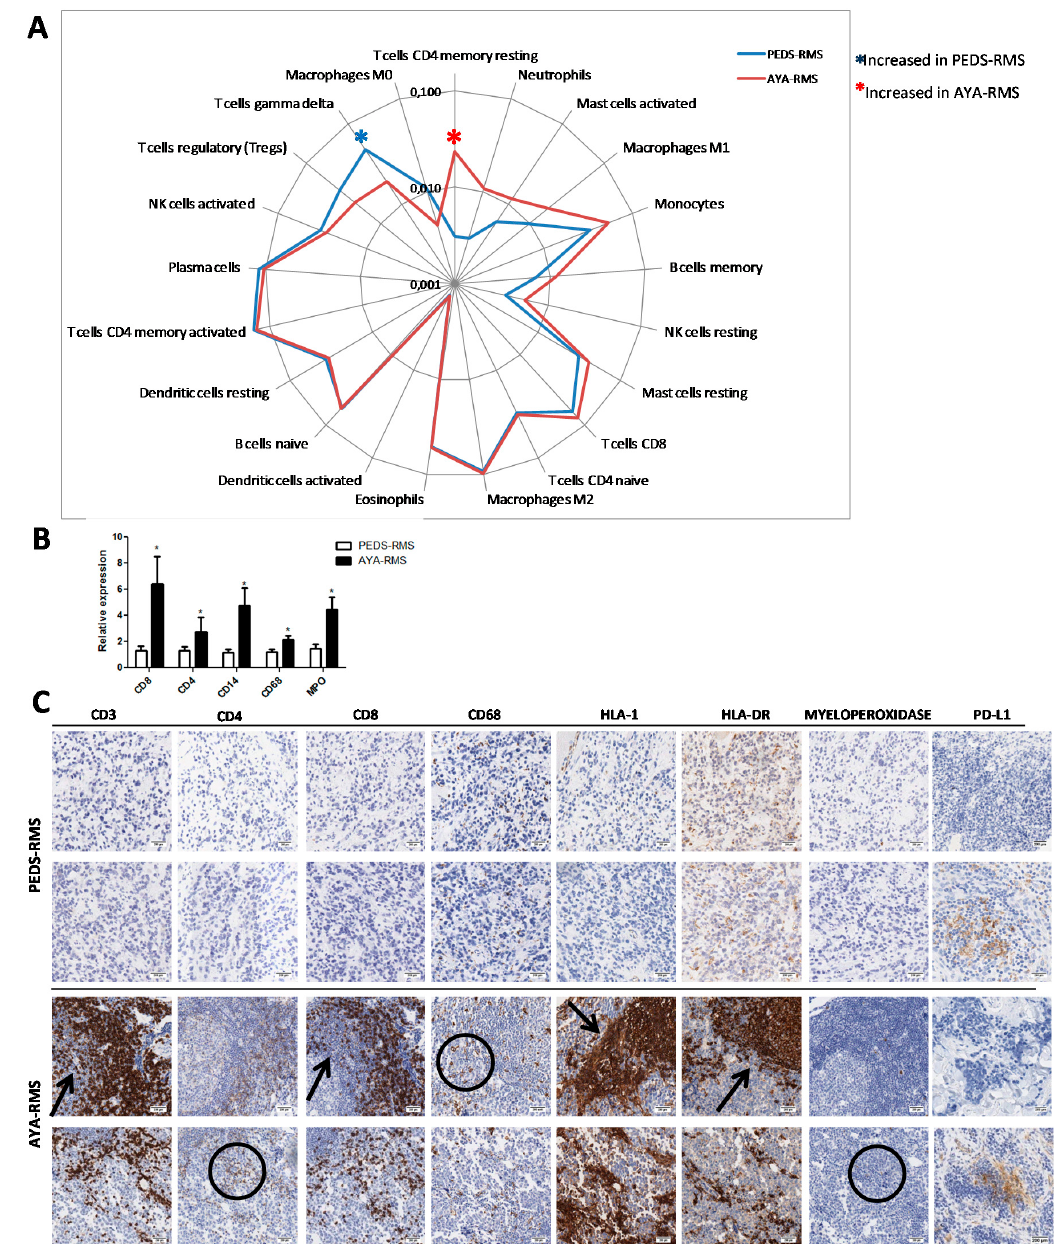
Figure 5. Immune cells invade and infiltrates tumor space in AYA-RMS. ( A ) Radar plot shows enrichment of T cell ϒ δ in PEDS-RMS whereas T cell CD4 memory resting in AYA-RMS (n = 49). ( B ) Real Time graphs show an increase of CD4, CD8, CD14, CD68 and MPO in AYA-RMS compared to PEDS-RMS n = 10 for each group). Data are expressed as mean ± SEM. * p < 0.05 ( C ) Representative images of IHC analysis of different immune cells population (n = 10; original Magnification 200×) in AYA- and PEDS-RMS tumor tissues. CD3, CD8, HLA-1 and HLA-DR are distributed in a pushing- fashion (as indicated by arrows), while positive CD4, CD68 and MPO are intermingled distributed